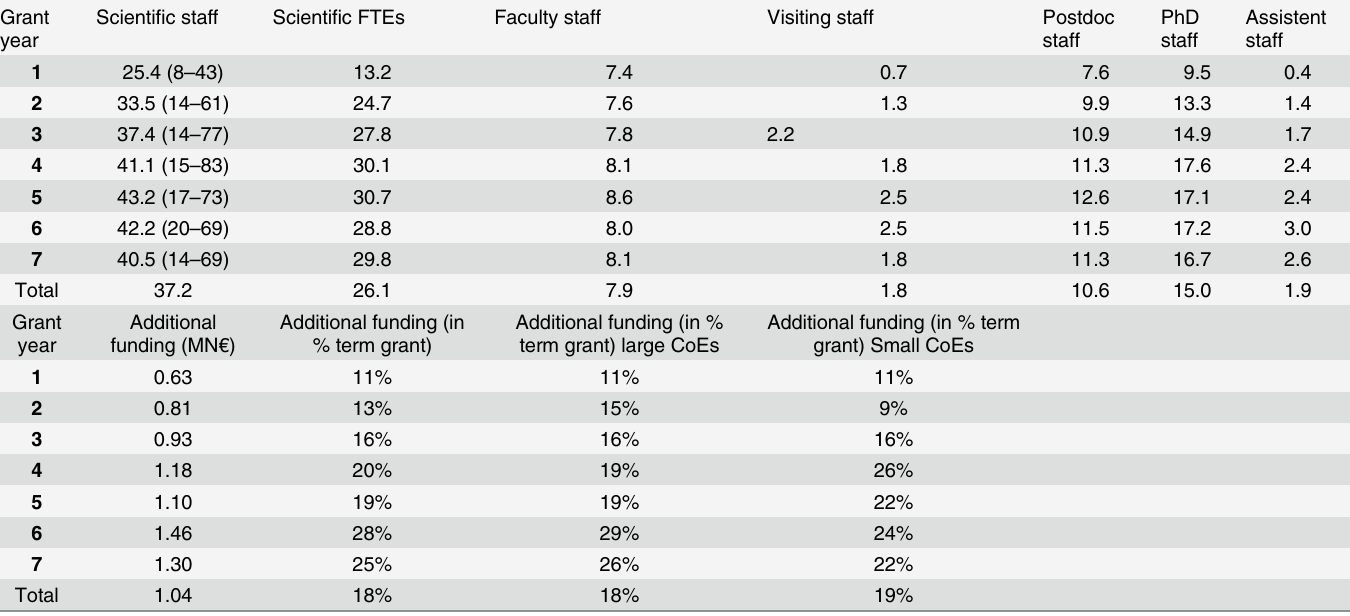
Table 3. Developments in scientific staff and additional funding over time for